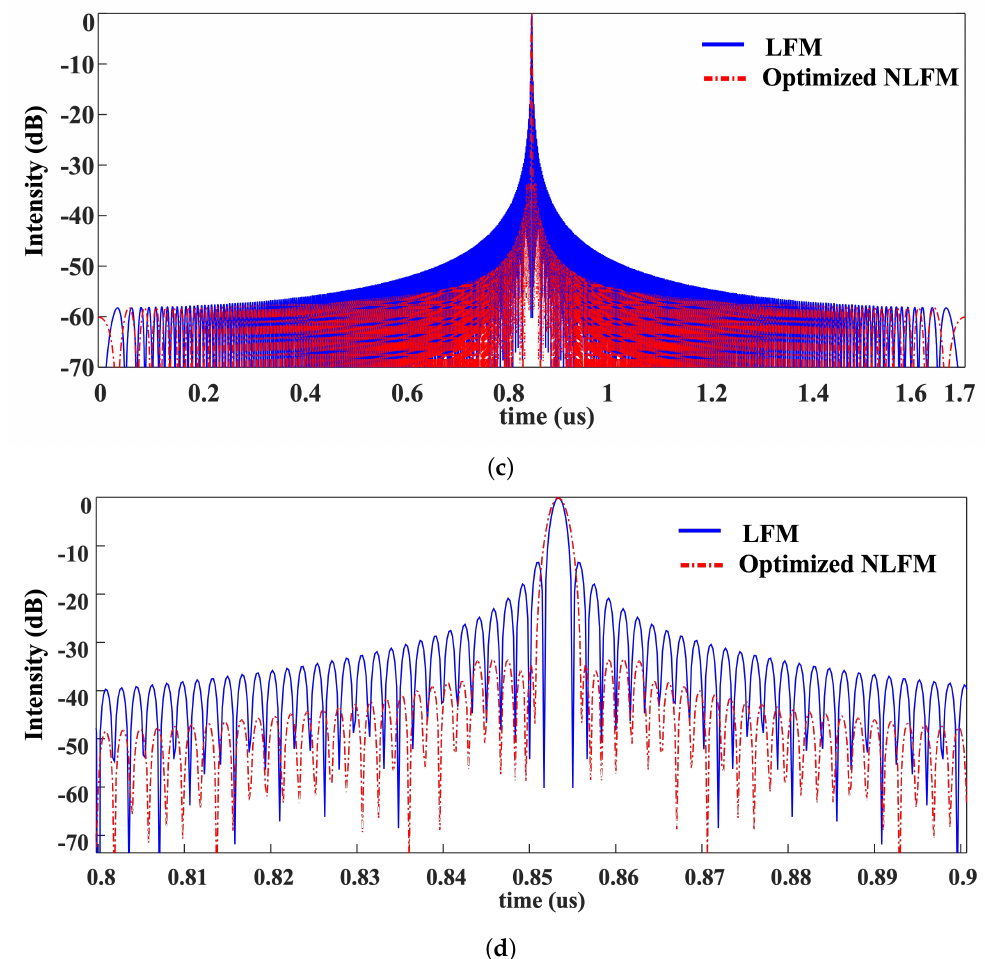
Figure 5. Comparisons of the optimized NLFM signal and the LFM signal: ( a ) time-frequency function, ( b ) waveforms, ( c ) IRF, and ( d ) zoom in the IRF.